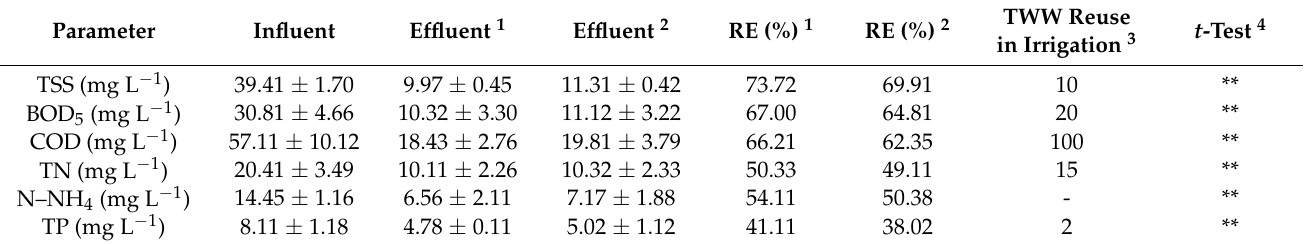
Table 2. Main chemical composition of the treated wastewater (TWW) from inlet to outlet of the HSSFs CW. Removal efficiency (RE) from March to October 2014/2018. For each unit, five-year average values ( ± standard deviation) are shown ( n =